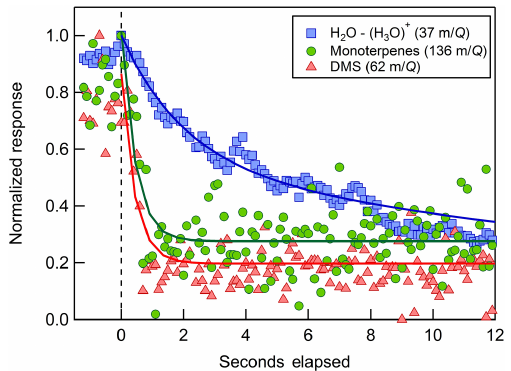
Figure 8. Probability density functions of benzene signals (% to- tal ion current, 1Hz) for ambient and baseline sampling periods. The bimodal distribution corresponds to abrupt temporal shifts in ion current from benzene monomers to protonated water clusters. These shifts correspond to switches in benzene gas cylinders rather than changes in ambient specific humidity, indicating the bimodal distribution is driven by trace water vapor contaminants in the ben- zene gas